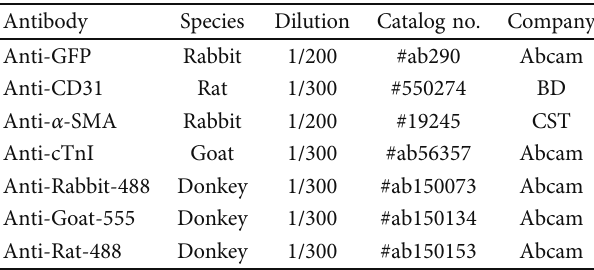
Table 4: Antibodies used for immuno fl